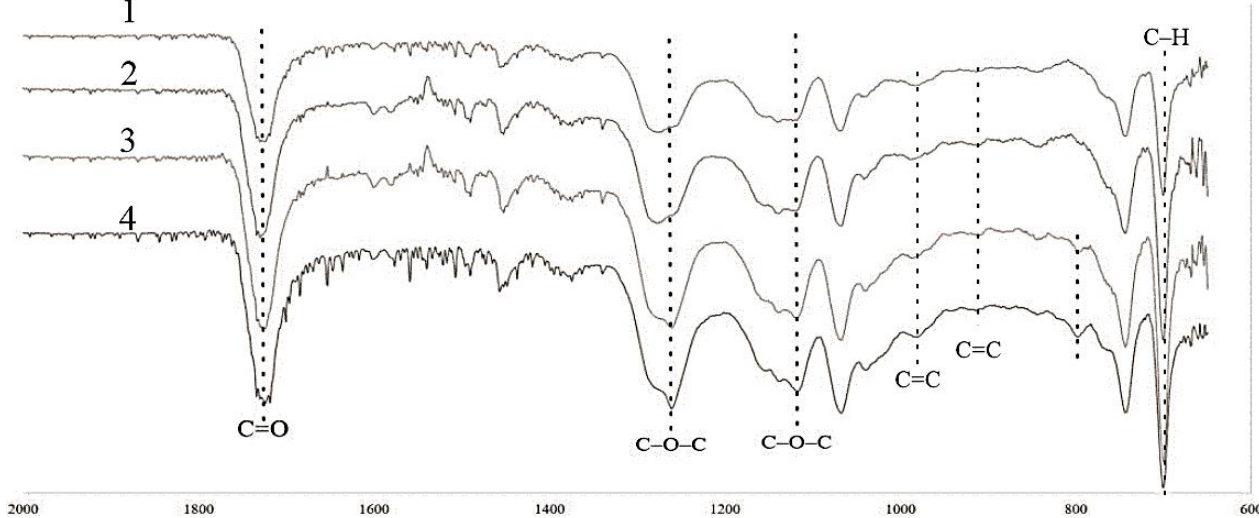
Figure 7. IR spectroscopy of samples: 1—neat UPR; 2—UPR + MWCNTs; 3—UPR + MWCNTs + oligomer microwave treatment; 4—UPR + microwave treatment MWCNTs.